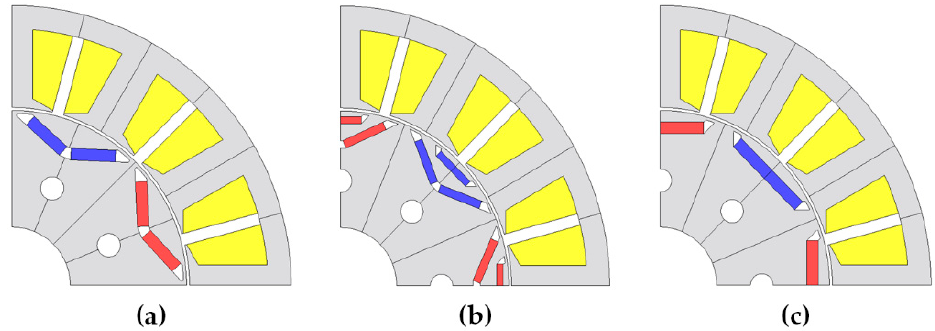
Figure 2. ( a ) Single layer V-shape magnet rotor. ( b ) Dual layer delta-shape magnet rotor. ( c ) Single layer flat-shape magnet rotor.